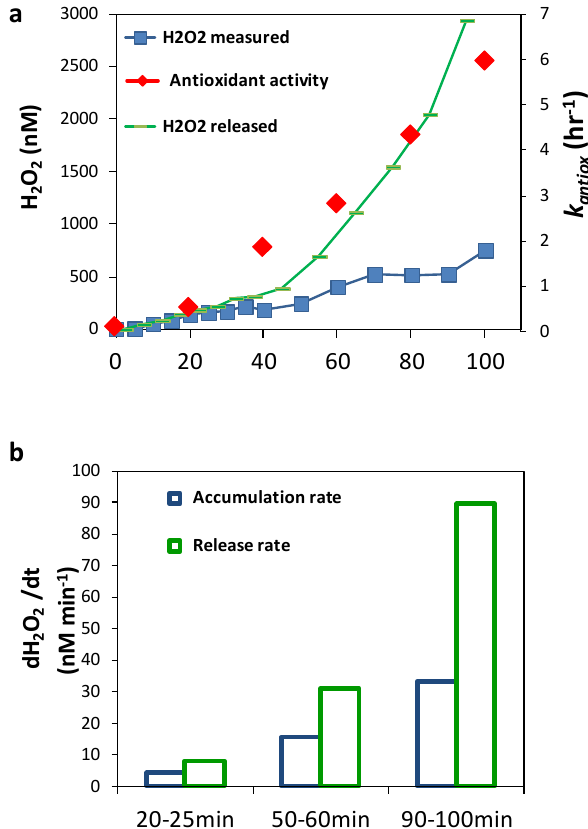
Figure 2. Quantification of H 2 O 2 release by Stylophora pistillata . Data from a short-term experiment are plotted to demonstrate the corrections made to account for H 2 O 2 loss due to antioxidant ac- tivity. (a) The measured variables are H 2 O 2 concentrations (blue squares) and antioxidant activities (red diamonds). Since H 2 O 2 is degraded by the antioxidants, its measured concentrations are lower than those released by the coral (green lines). The coral-released H 2 O 2 is calculated for small time intervals using Eq. (5), and is then added up. (b) Rates of H 2 O 2 release (green bars, Eq. 5) are cal- culated for each time interval from H 2 O 2 accumulation rates (blue bars, Eq. 4) and k antiox . These rates grow apart with time due to increased antioxidant